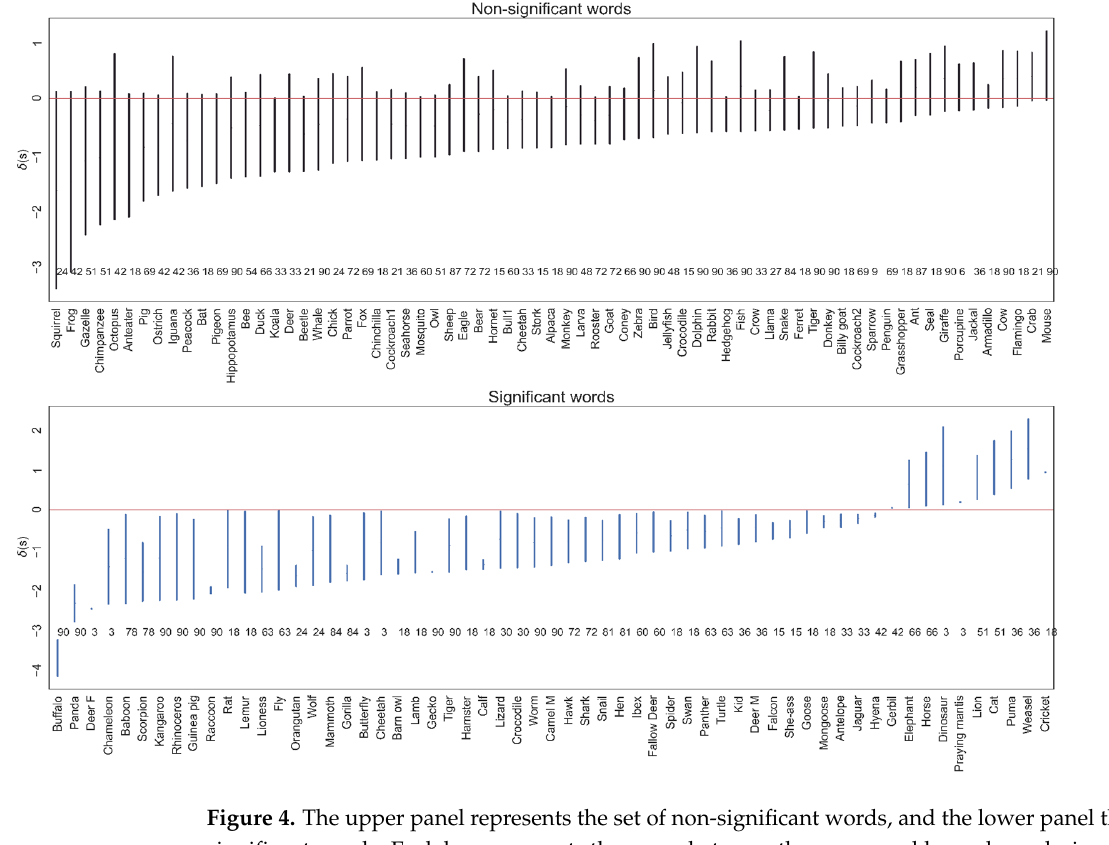
Figure 4. The upper panel represents the set of non-significant words, and the lower panel the set of significant words. Each bar represents the range between the upper and lower boundaries given by the bootstrap test. The numbers represent the number of values out of 90 networks that each word received.